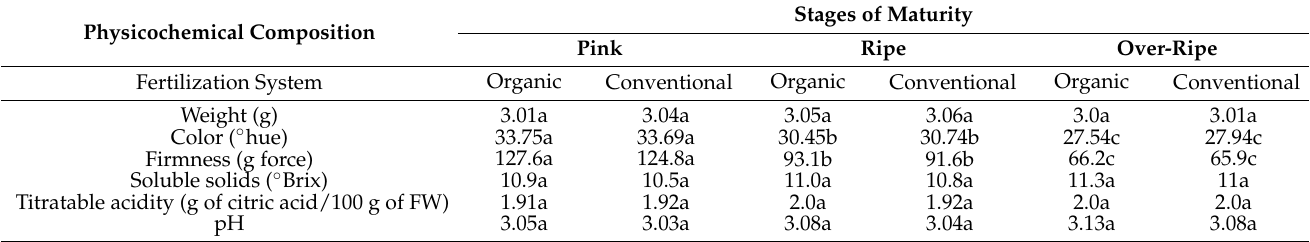
Table 4. Physicochemical composition of raspberry in three stages of maturity with two fertilization systems. Stages of Maturity Physicochemical Composition Pink Ripe Over-Ripe Fertilization System Organic Conventional Organic Conventional Organic Conventional Weight